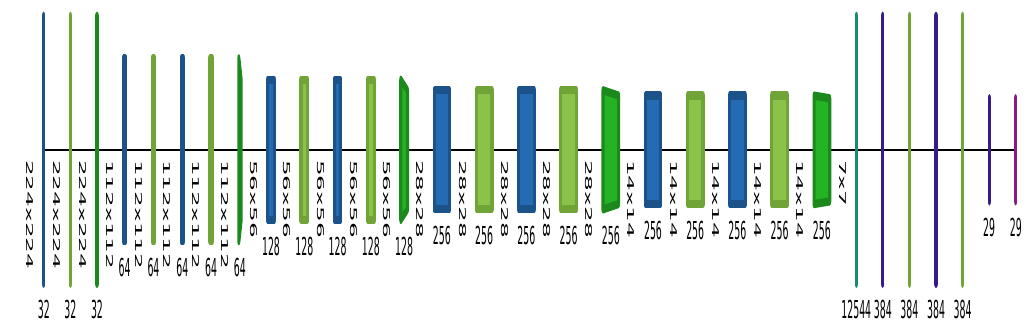
Figure 7. Deep convolutional network after pruning; The color-coded boxes represent the layers in the model. Convolutional layers are blue ( ), batch normalization layers are lime ( ) and max-pooling layers are forest green ( ); these are followed by a flatten layer, shown in emerald green ( ), a fully connected layer in violet ( ) and the Softmax output in magenta ( ). The number of dimensions in each layer is shown beside/below that layer.